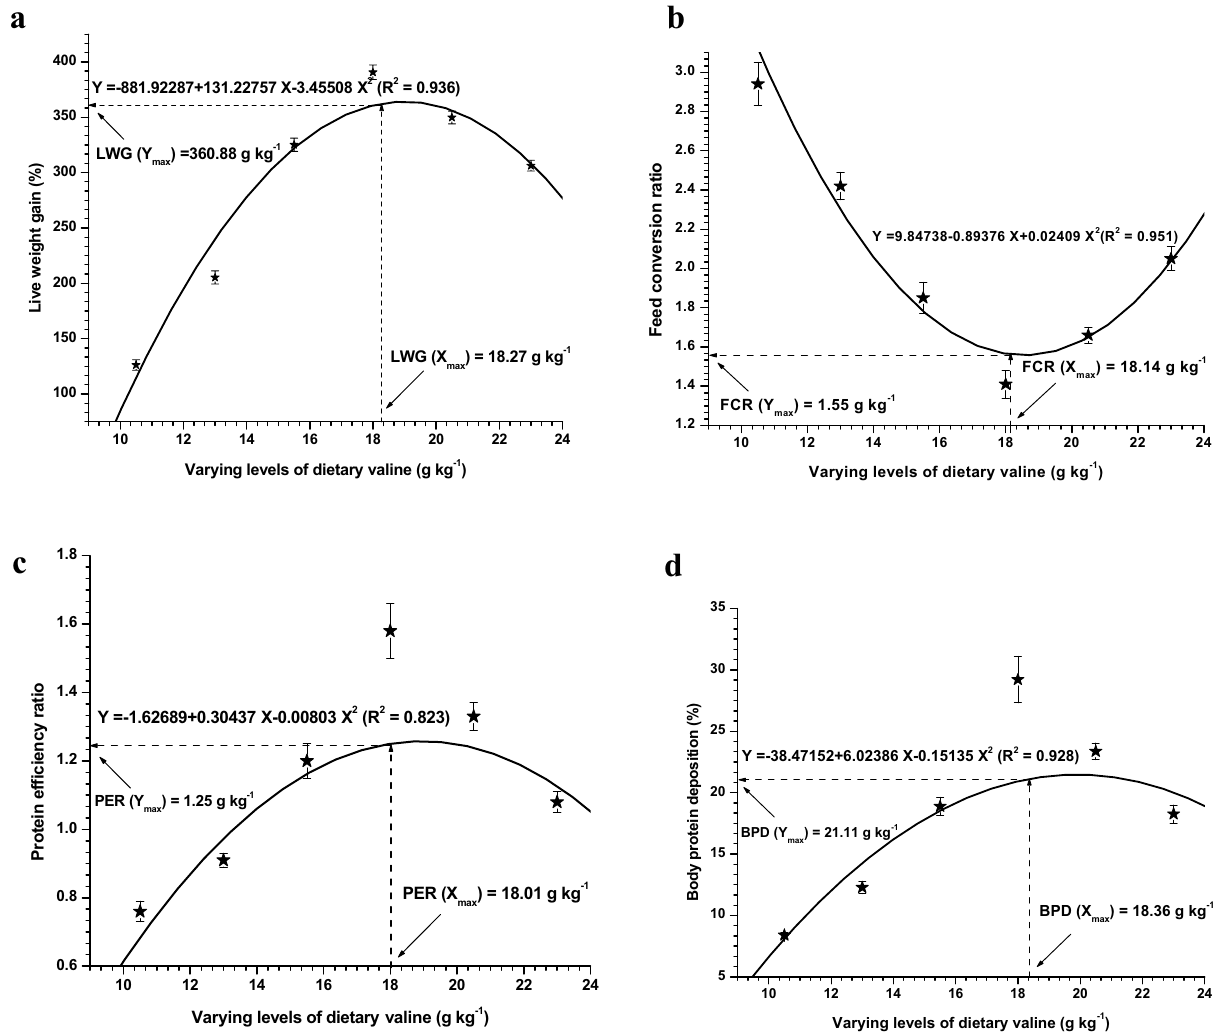
Figure 1. Second-degree polynomial relationship between ( a ) live weight gain (LWG%), ( b ) feed conversion ratio (FCR), ( c ) protein efficiency ratio (PER) and ( d ) body protein deposition (BPD) to dietary valine levels of Oncorhynchus mykiss (g kg −1 ).